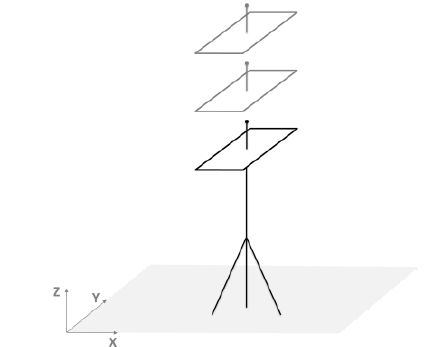
Figure 2. Acquisition of vertical images at different